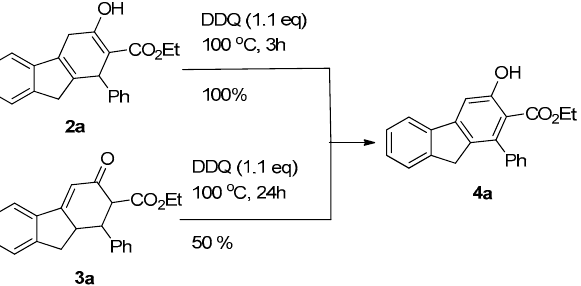
7 Table 1. Optimization for reaction of 1a with ethyl acetoacetate leading to 2a and 3a 1 .